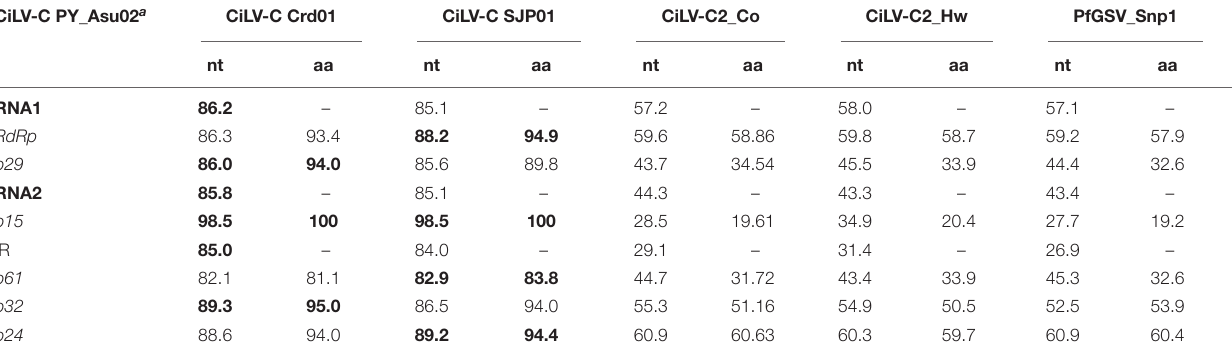
TABLE 4 | Nucleotide (nt) and deduced amino acid (aa) sequence identities between CiLV-C_PY_Asu02 and other members of the genus Cilevirus. CiLV-C PY_Asu02 a CiLV-C